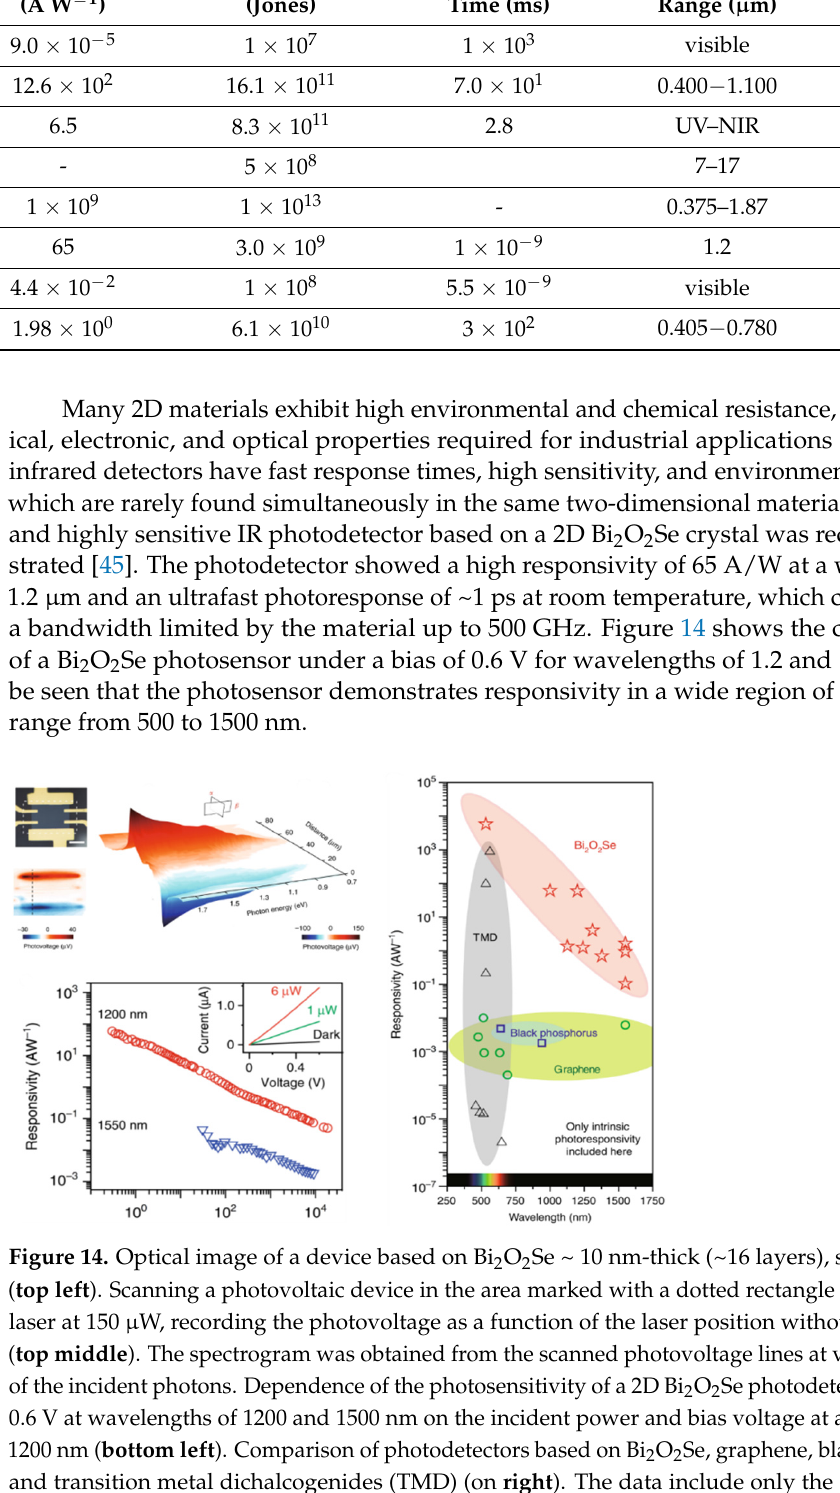
Figure 15. Flexible 2D arrays of Bi 2 O 2 Se photodetectors. Images of 2D Bi 2 O 2 Se photodetectors and arrays on mica (top left). The inset shows the photoresponse of one of the photodetectors when the substrate is bent with a deformation of up to 1%. The current rises at 1200 nm IR illumination with a power of about 100 μ W. Photocurrent images with shapes 1, 2, 3, and 4 were obtained under illumination with light at 1550 nm, 1310 nm, 1200 nm, and 665 nm, respectively [45]. The 2D Bi 2 O 2 Se photodetector quantifies the infrared reflection of the sample struc- ture by measuring the detected photocurrent. When scanning the structure, the recorded values of the reflection signals are converted into an image. For different wavelengths— 1.5, 1.3, 1.2 μ m, and 665 nm—photocurrent images were obtained with shapes 1, 2, 3, and 4, respectively. The imaging capability, combined with high responsivity, ultra-fast pho- toresponse, and chemical stability, makes 2D Bi 2 O 2 Se a promising candidate for the im- plementation of ultra-fast and sensitive infrared photosensors for image recognition op- erating at room temperature.